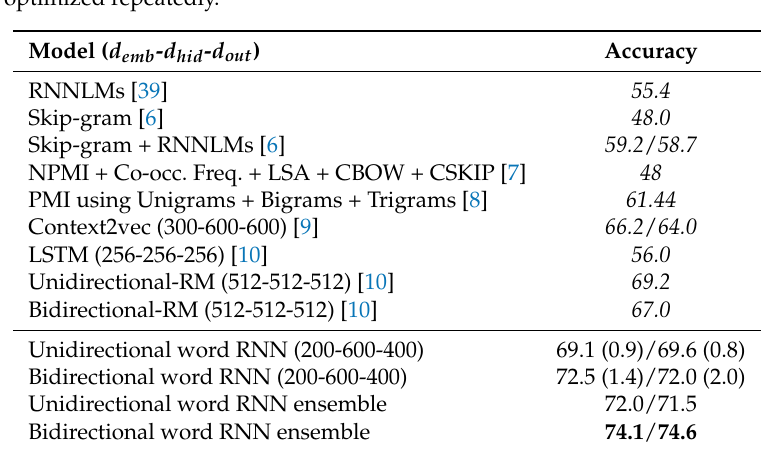
Table 2. Accuracy results (%) for the MSR Challenge dataset. The accuracies in italic were from their corresponding publications. We present the accuracy results of the development and test sets using a slash if they were measured separately. We report the average accuracy with the standard deviation if a model was optimized